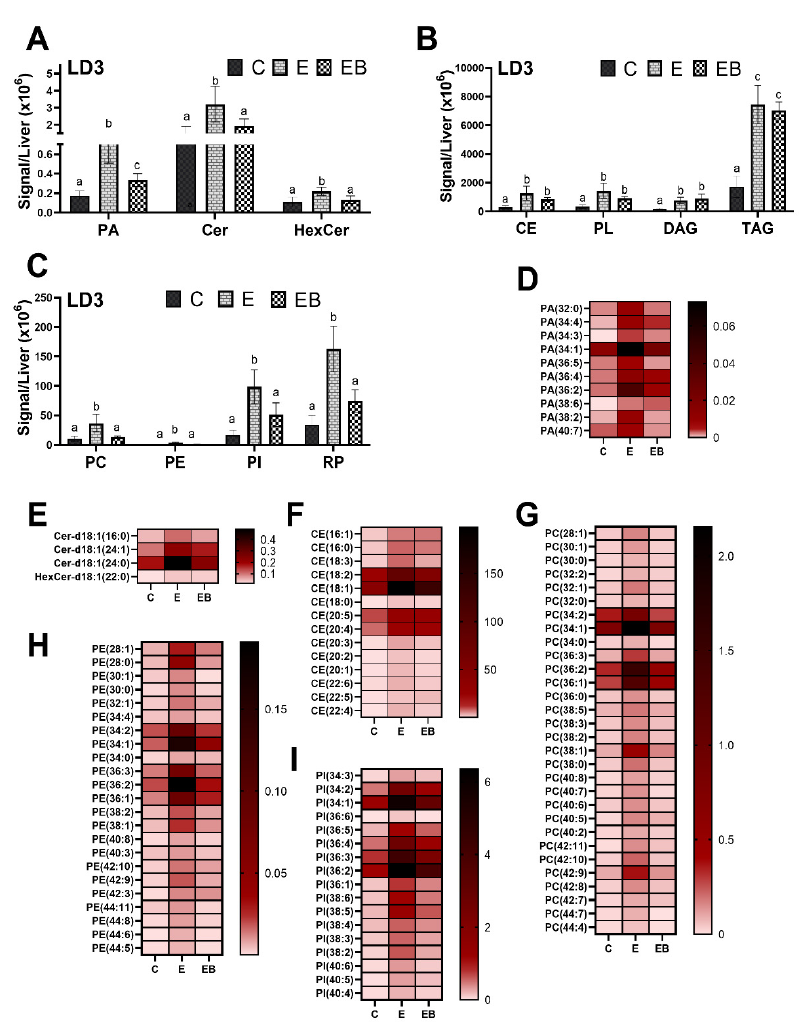
(Table S8). Other PA species, such as PA (34:4), PA (36:4), PA (36:2), and PA (38:6) were unaltered in these LD3.